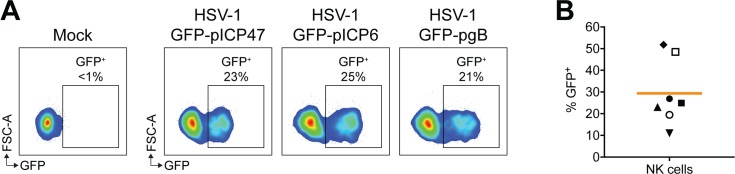
HSV-1 infects human NK cells.(A) PBMCs were cultured with mock infected inoculum or inoculum infected with HSV-1 expressing GFP under different viral promoters (ICP47, ICP6 or gB as specified) for 1 day. Infection of NK cells (viable CD3–CD56+ cells) was determined by flow cytometry detection of GFP. (B) Frequency of NK cell infection with HSV-1 GFP-pICP47 performed as in (A), for seven donors. Symbols represent individual donors, and bar indicates mean.